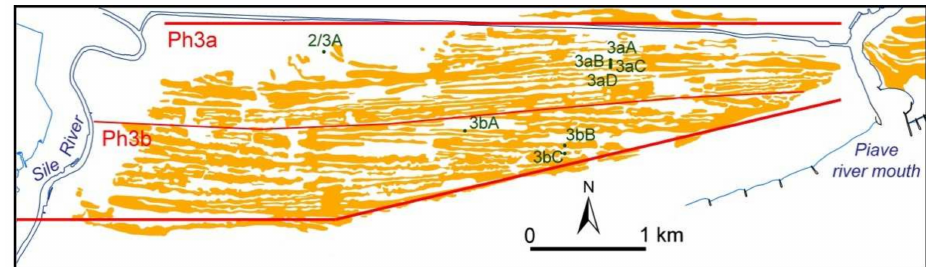
Figure 4. Arrangement of the ancient sandy ridges that define the third progradation phase (Ph3) (rectangle C in Figure 1). Ph3a and Ph3b are two subgroups of Ph3. The green dots indicate core locations.